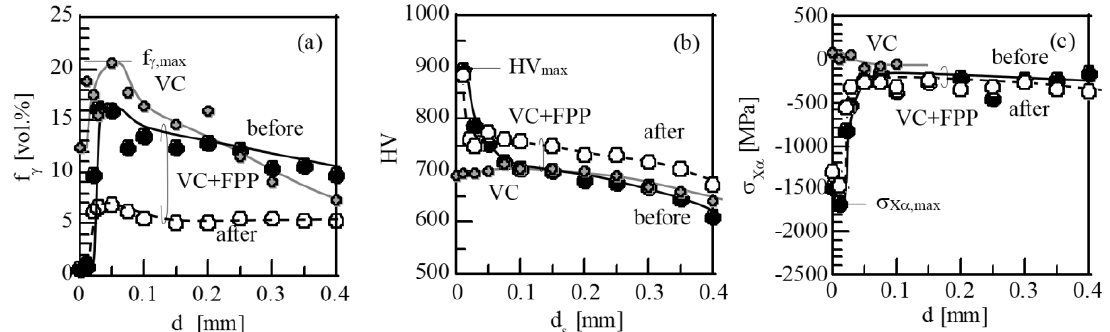
Figure 12. Variations of ( a ) volume fraction of retained austenite ( f γ ), ( b ) Vickers hardness (HV), and ( c ) residual stress ( σ X α ) as a function of depth from surface ( d s ) in TM ( to vacuum carburization and fine particle peening (VC + FPP). Solid and open marks represent before and after rotary bending fatigue tests, respectively. Gray marks ( as-vacuum-carburized TM steel